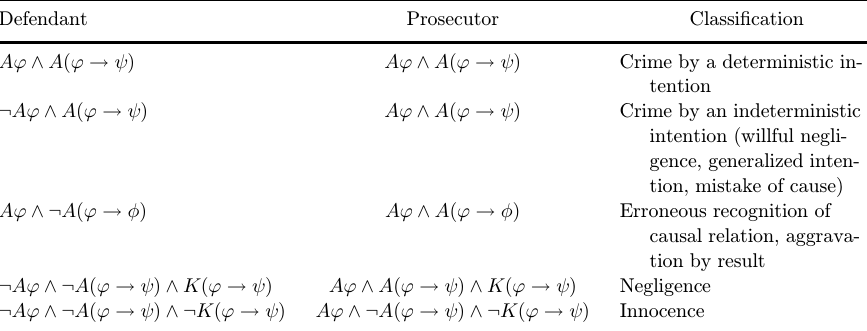
Table 4. Classi¯cation criteria for precedents.